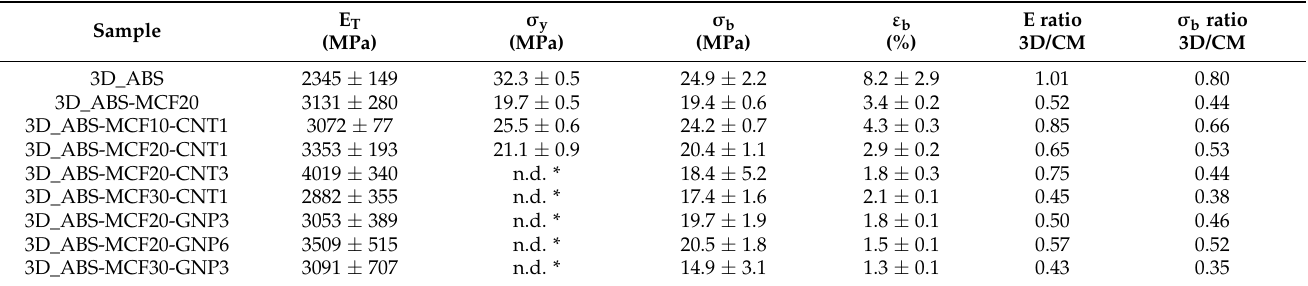
Figure 13. Representative stress–strain curves of multiscale composite 3D-printed samples as a function of different percentages of MCF and CNT ( a ) or GNP ( b ). Table 9. Tensile modulus (E T ), yield stress ( σ y ), stress at break ( σ b ), and deformation at break ( ε b ) of quasi-static tensile properties of ABS multiscale 3D-printed